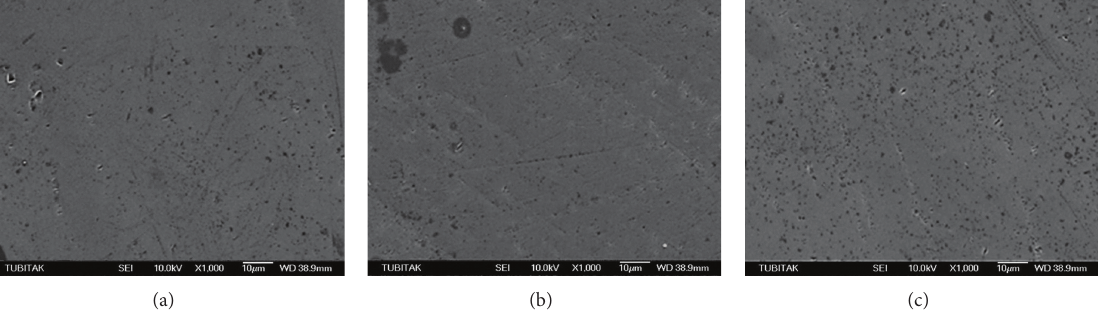
Figure 7: Scanning electron micrographs of PEE-C, PEE-DT, and PEE-TP groups presented similar surface morphology with small voids that were created during mechanical